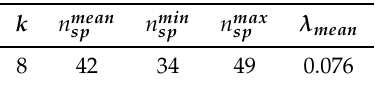
Table 2. Number of clusters ( k ), mean number of species per cluster ( n mean sp ), minimum number